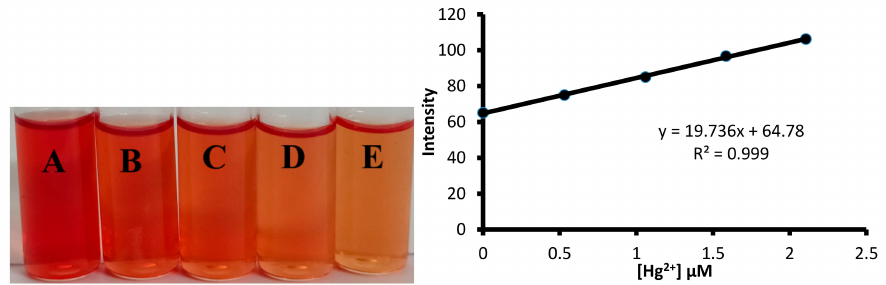
Figure 16. The determination of limit of detection value of 1 towards mercuric ions using the solution intensity method. ( Left ) Concentration of Hg 2 + ion in: A = 0.0 µ M; B = 0.53 µ M; C = 1.06 µ M; D = 1.58 µ M; E = 2.10 µ M. ( Right ) A graph showing the change in pixel intensity of the solution with an increase in the mercury ion